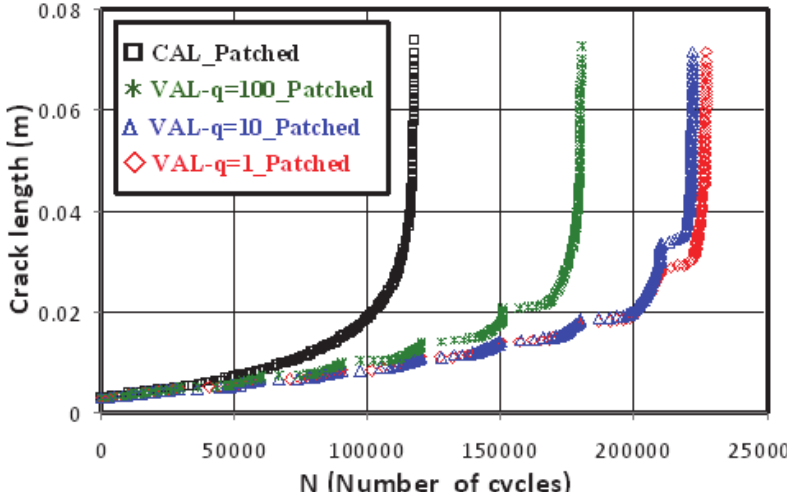
Figure 10: Influence of band overloading parameter “q” on fatigue life for patched crack repair at ORL=2.4.